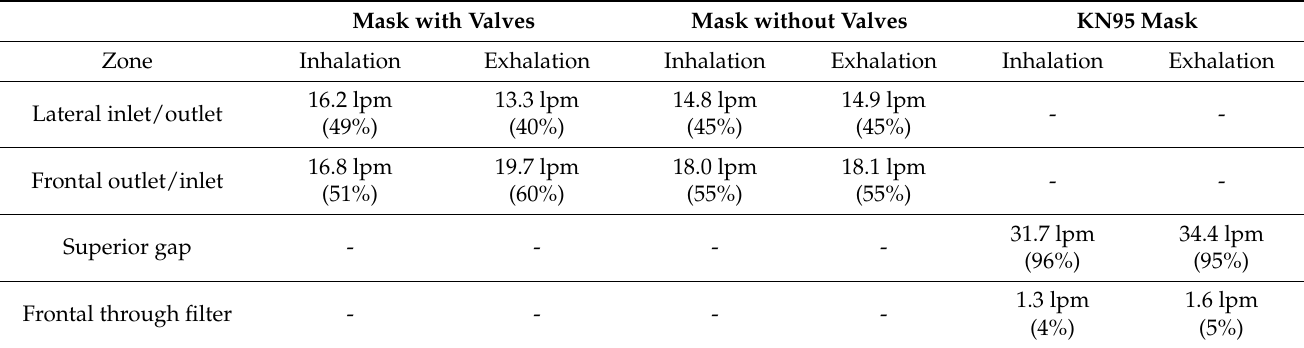
Table 5. Air flow through nose: percentages per zone and event for each mask considering filter at boundaries. Mask with Valves Mask without Valves KN95